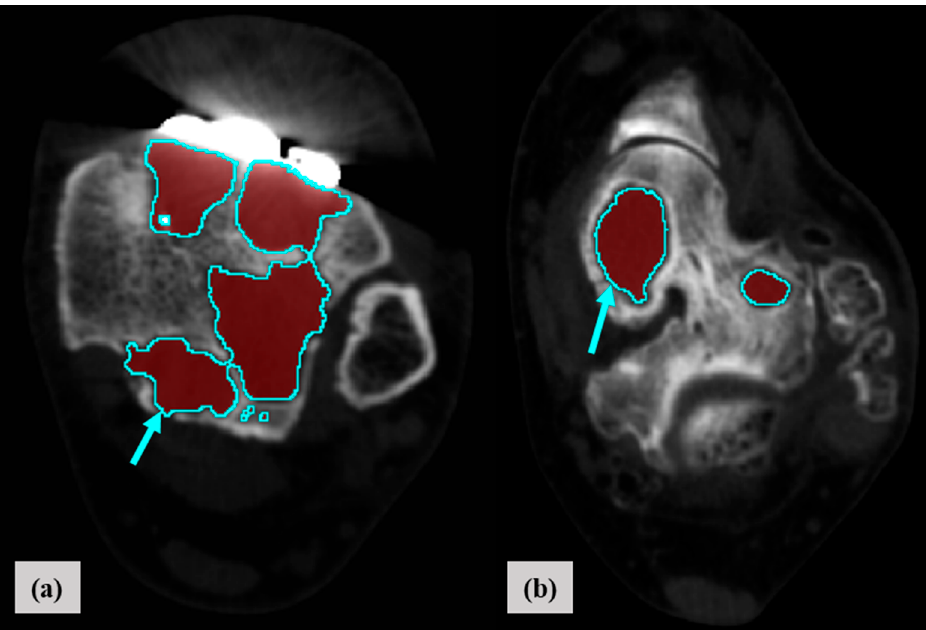
Figure 2. Segmentation of osteolysis in the distal tibia ( a ) and talus ( b ) based on 3D-CT reconstruction (red and blue indicate osteolysis and the sclerotic border of osteolysis, respectively).